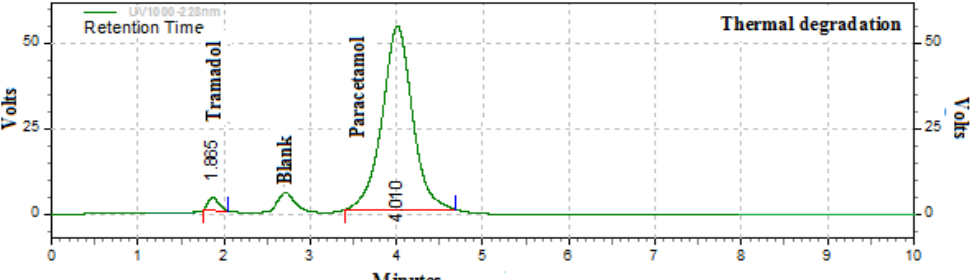
Figure 6. Representative chromatogram obtained from UV radiation in UV light cabinet.